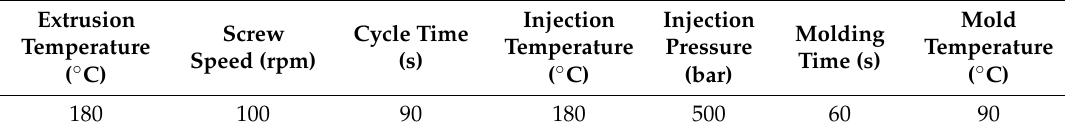
Table 4. Operating condition use for the extrusion and injection molding